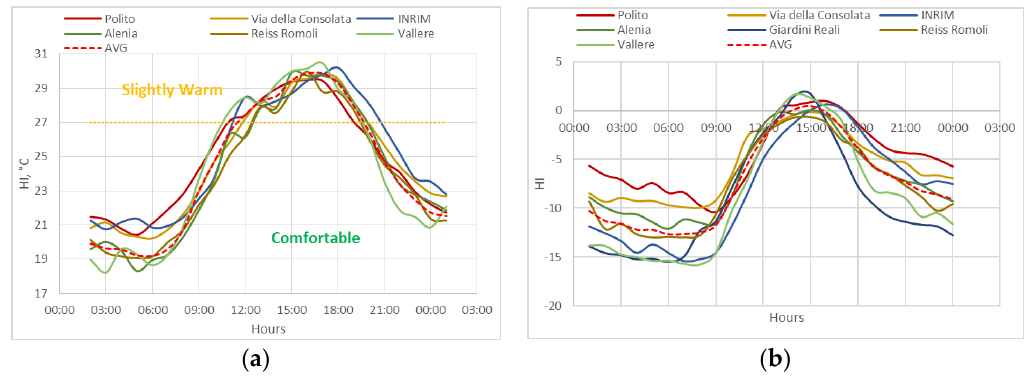
Figure 24. Heat Index (HI): ( a ) 25 August 2016 ( b ) 21 January 2016.